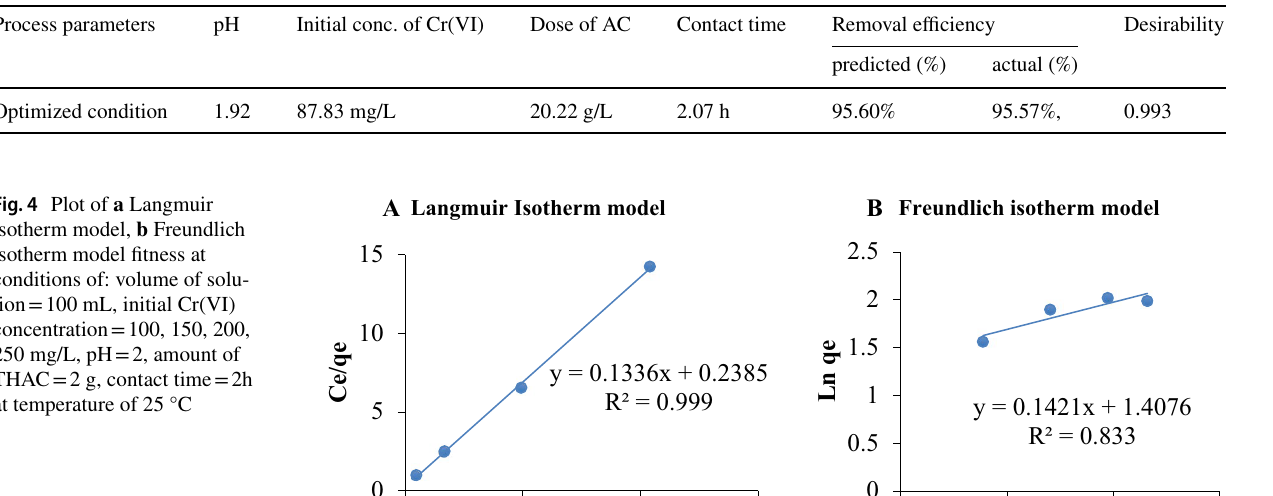
Langmuir Isotherm model Freundlich isotherm y = 0.1336x + 0.2385 R² = 0.999